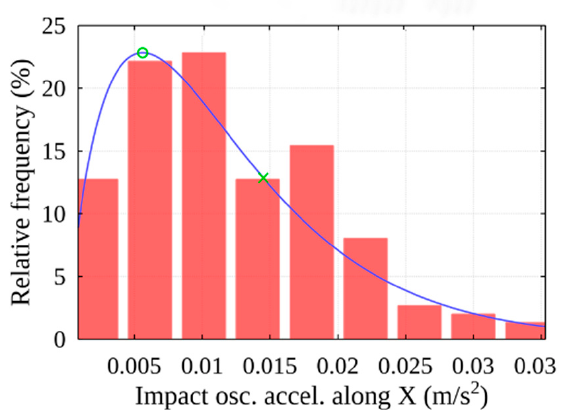
Figure 29. Histogram of peak amplitudes of acceleration along X-axis (using the chosen 73% threshold). In this case, the distribution of peak amplitudes is best matched by the gamma distri- bution function. Using histogram data, the threshold is detected and determined according to the proposed methodology marked as X (see Figure 29), according to the threshold accel- eration value of 0.014 m/s 2 selected according to the distribution function (see Figure 30).